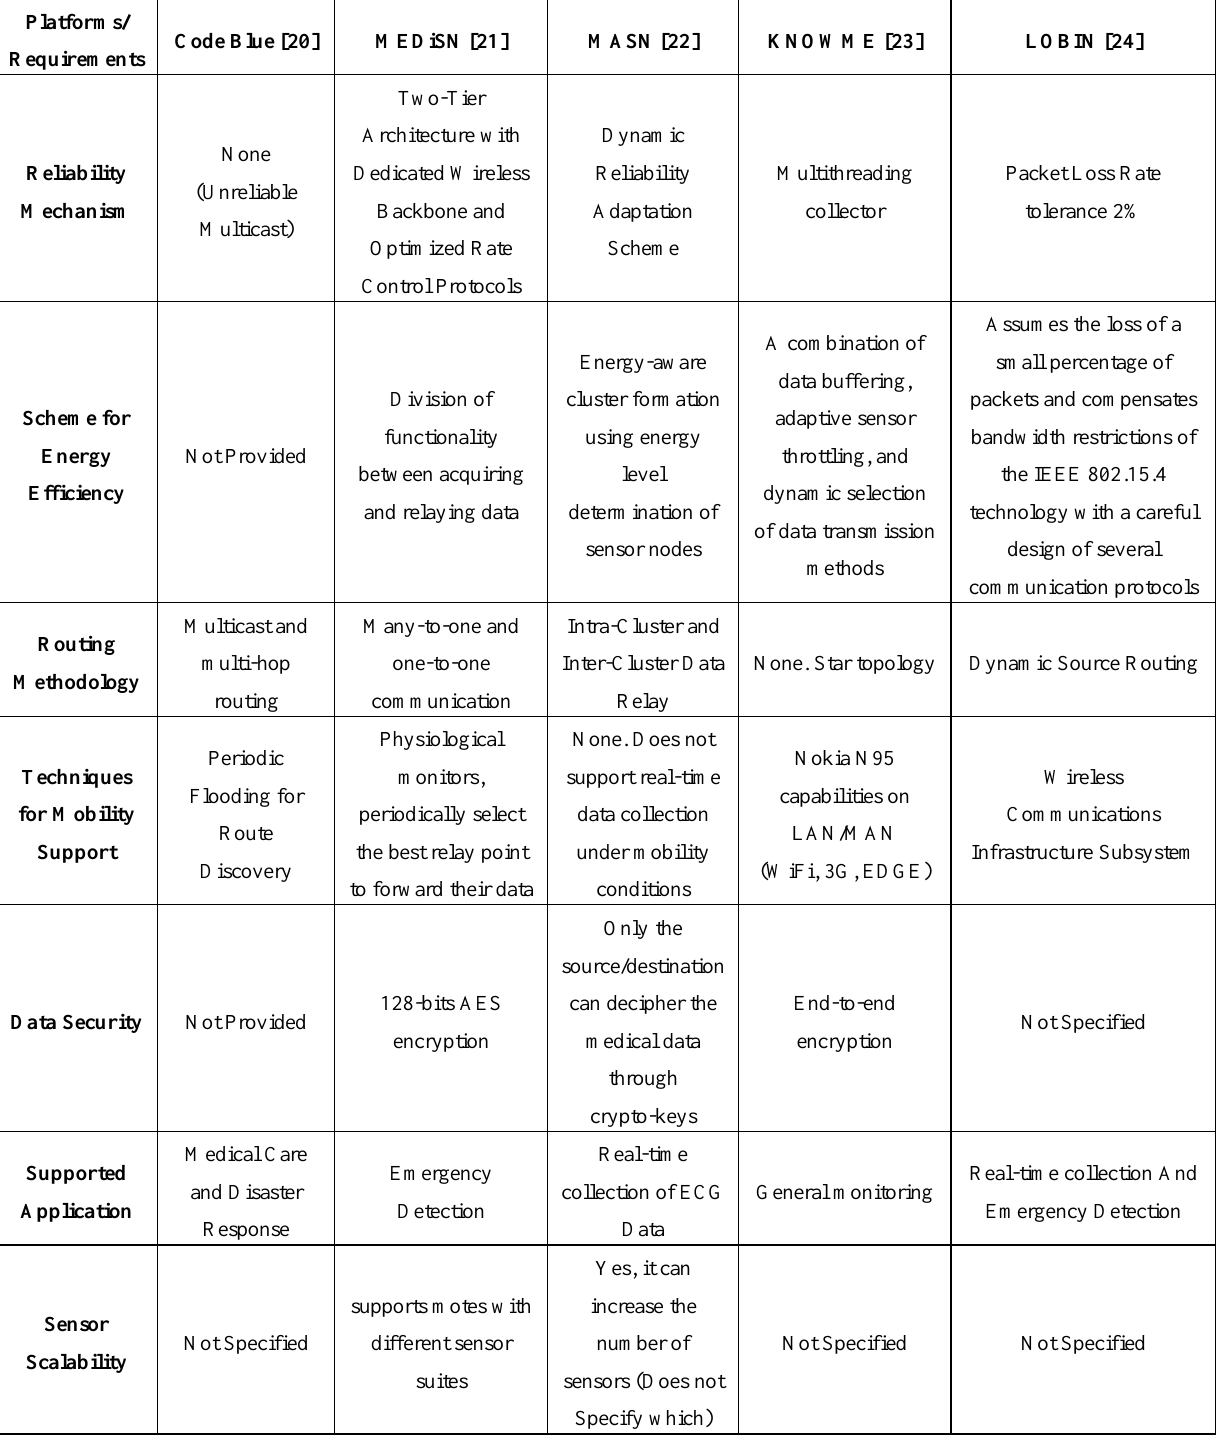
Table 1. E-Health Platform